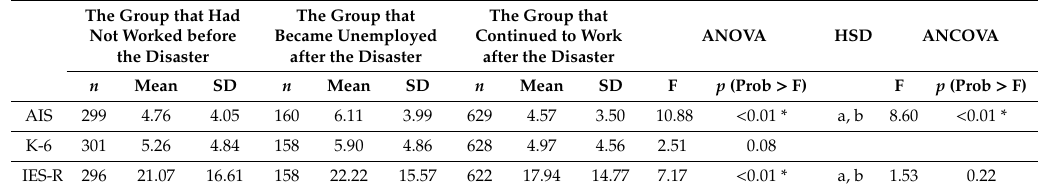
Table 6. The di ff erences in symptoms of each mental health condition between subgroups of residents a ff ected by the Great East Japan Earthquake regarding employment status before and after the disaster. The Group that Had The Group that The Group that Not Worked before Became Unemployed Continued to Work ANOVA HSD the Disaster after the Disaster after the Disaster